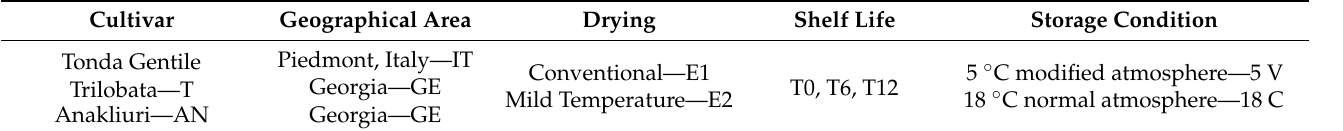
Table 1. Hazelnut samples, characteristics, and notations used in the text.